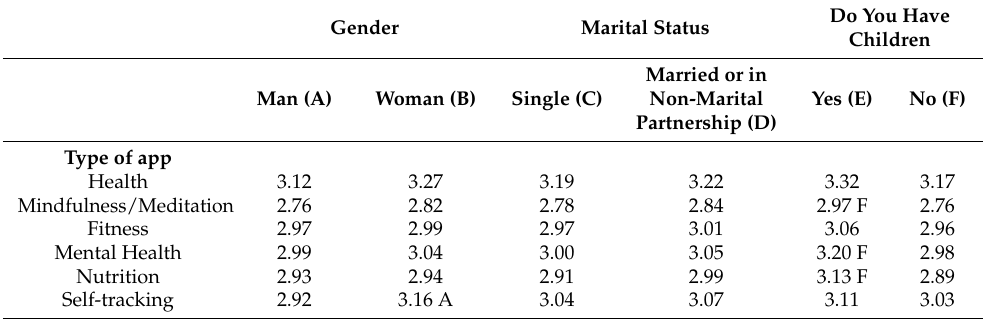
Table 4. Mean level of importance of health and wellbeing apps to Portuguese young adults